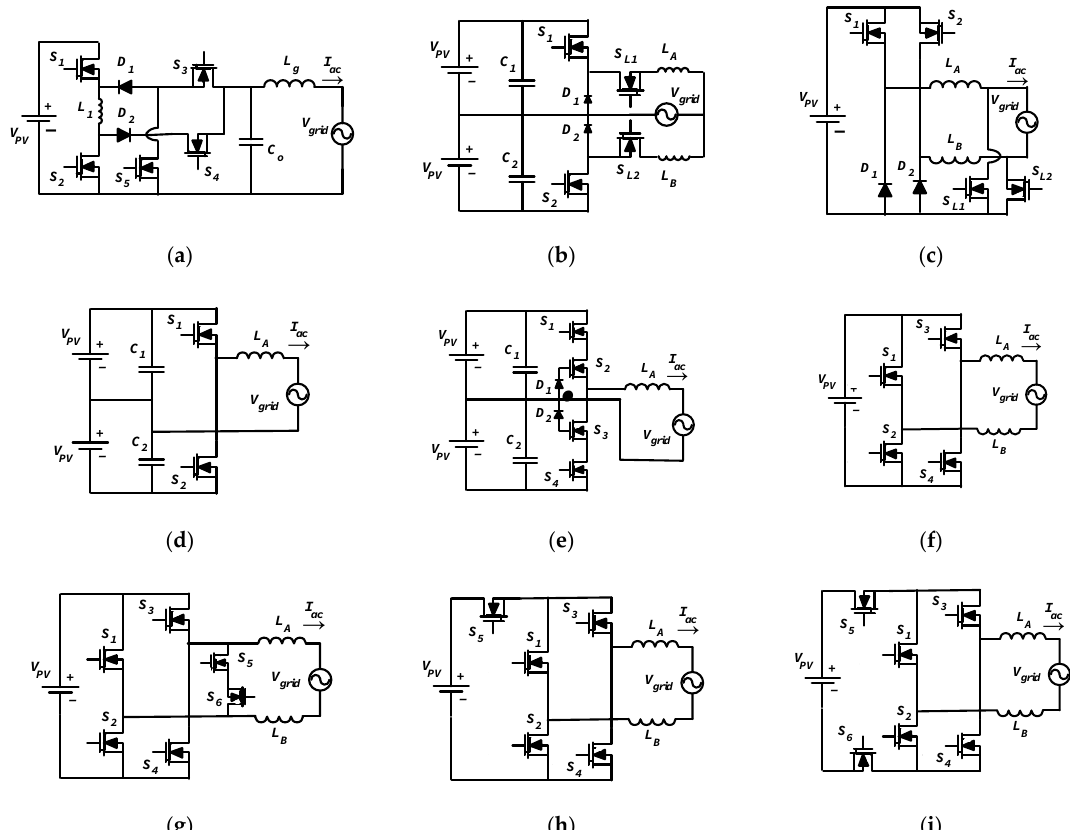
Figure 1. The main configurations of transformerless photovoltaic (PV) inverters in the literature.